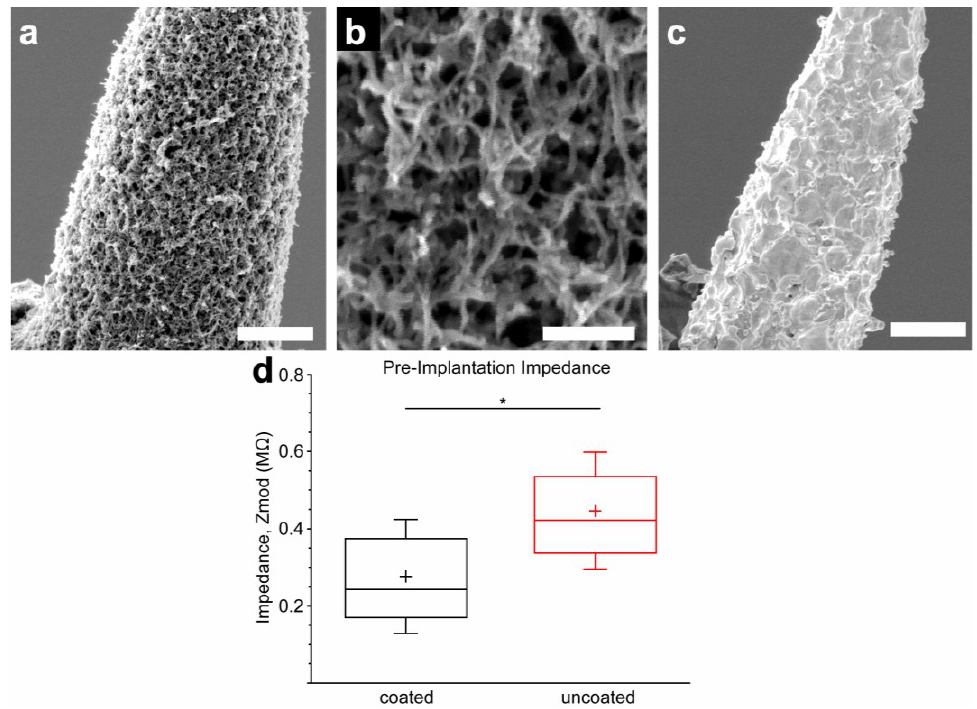
Figure 1. ( a ) SEM image of PEDOT/MWCNT/Dex-coated Pt/Ir microelectrode